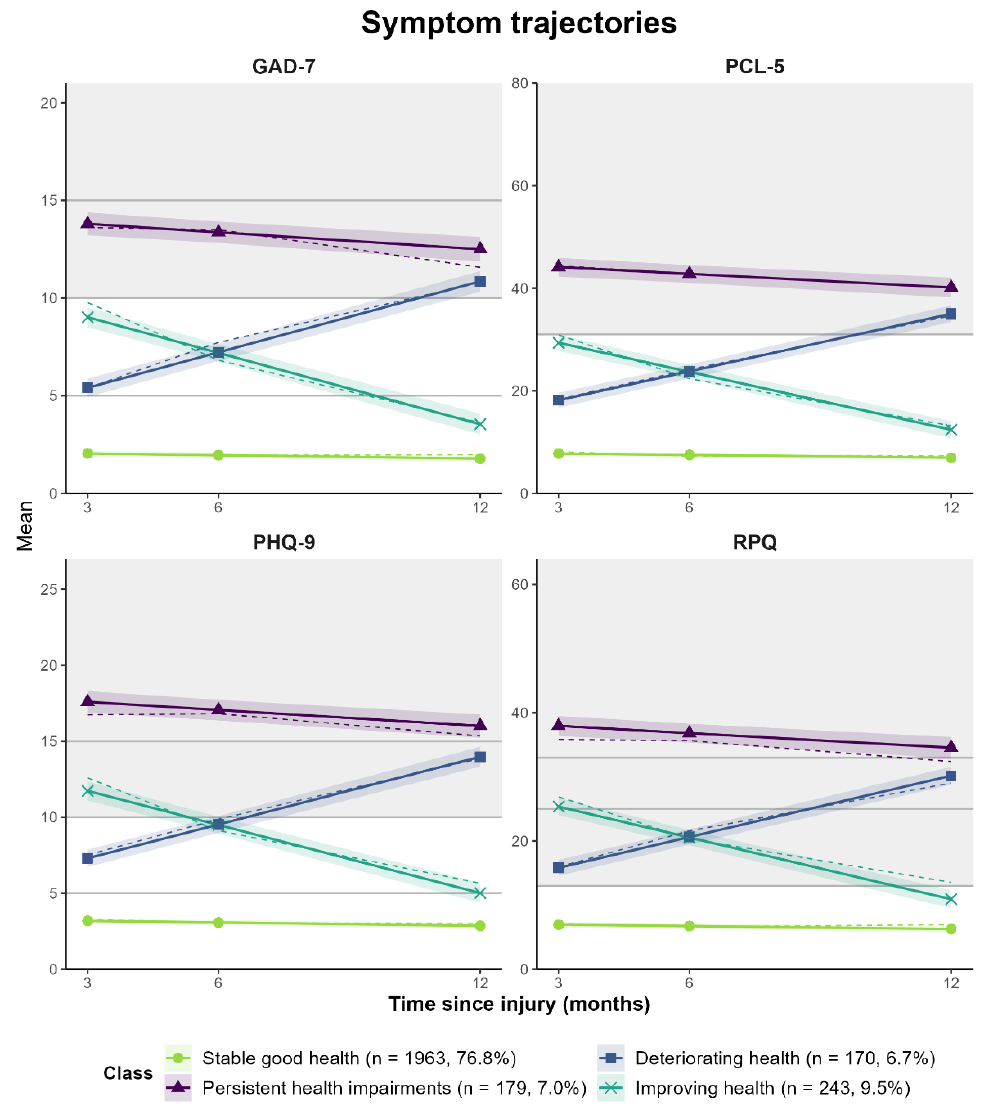
Figure 3. Symptom trajectories (GAD-7, PHQ-9, PCL-5 and RPQ) for the four-class solution. Solid, colored lines indicate predicted trajectories, dashed lines the observed values. Shaded areas around lines indicate 95% confidence intervals for predicted values. Gray lines mark cut-off values for cat- egorical classification of outcomes (GAD-7: 5 = mild, 10 = moderate, 15 = severe; PHQ-9: 5 = mild, 10 = moderate, 15 = severe; RPQ: 13 = mild, 25 = moderate, 33 = severe; PCL-5 ≥ 31: PTBS screening). Gray areas mark values above the cut-offs for clinical relevance (GAD-7 ≥ 10; PHQ-9 ≥ 10; PCL-5 ≥ 31; RPQ ≥ 13).